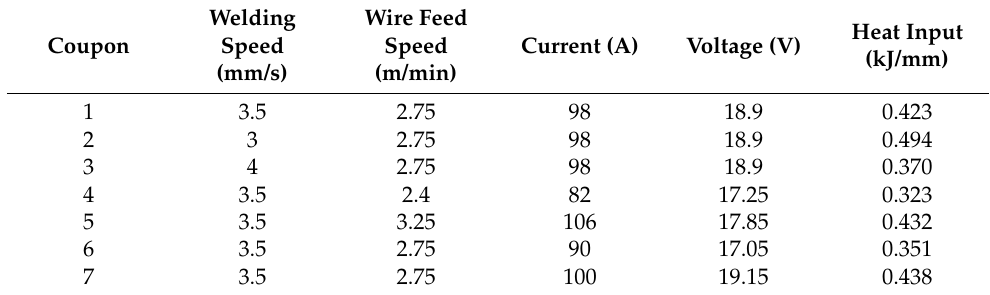
Table 2. Welding parameters for GMAW on duplex stainless steel S32001.